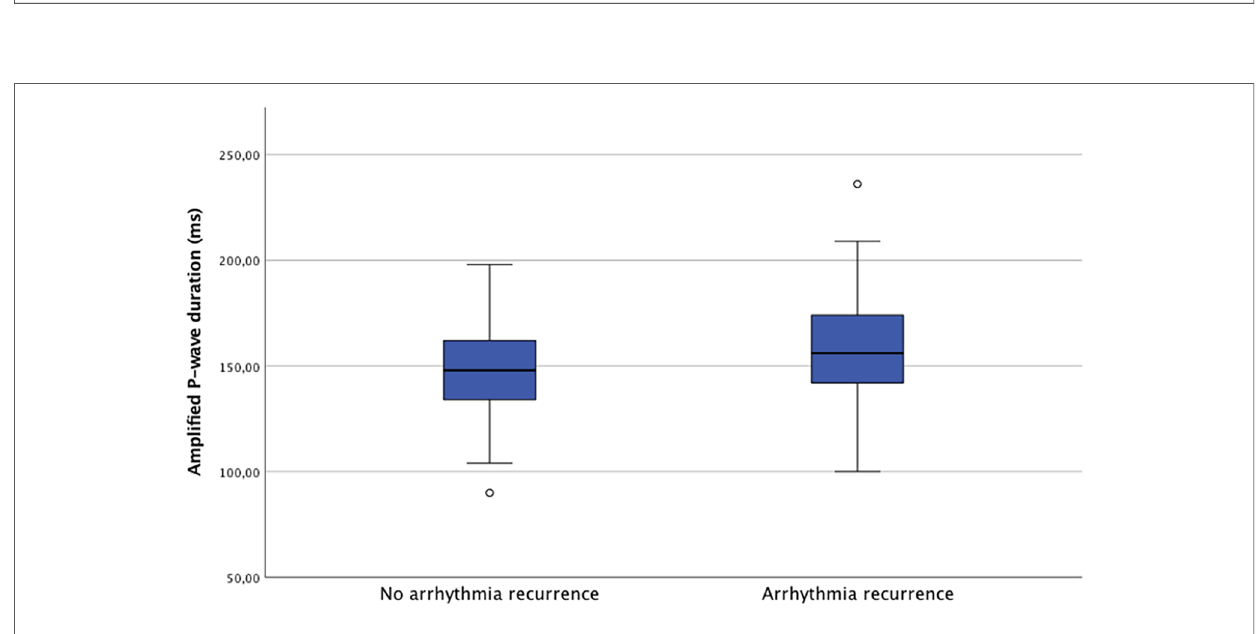
FIGURE 2 Kaplan-Meier for freedom from atrial arrhythmia relapse strati fi ed by APW duration (APW ≥ 150 ms vs. APW<150 ms).